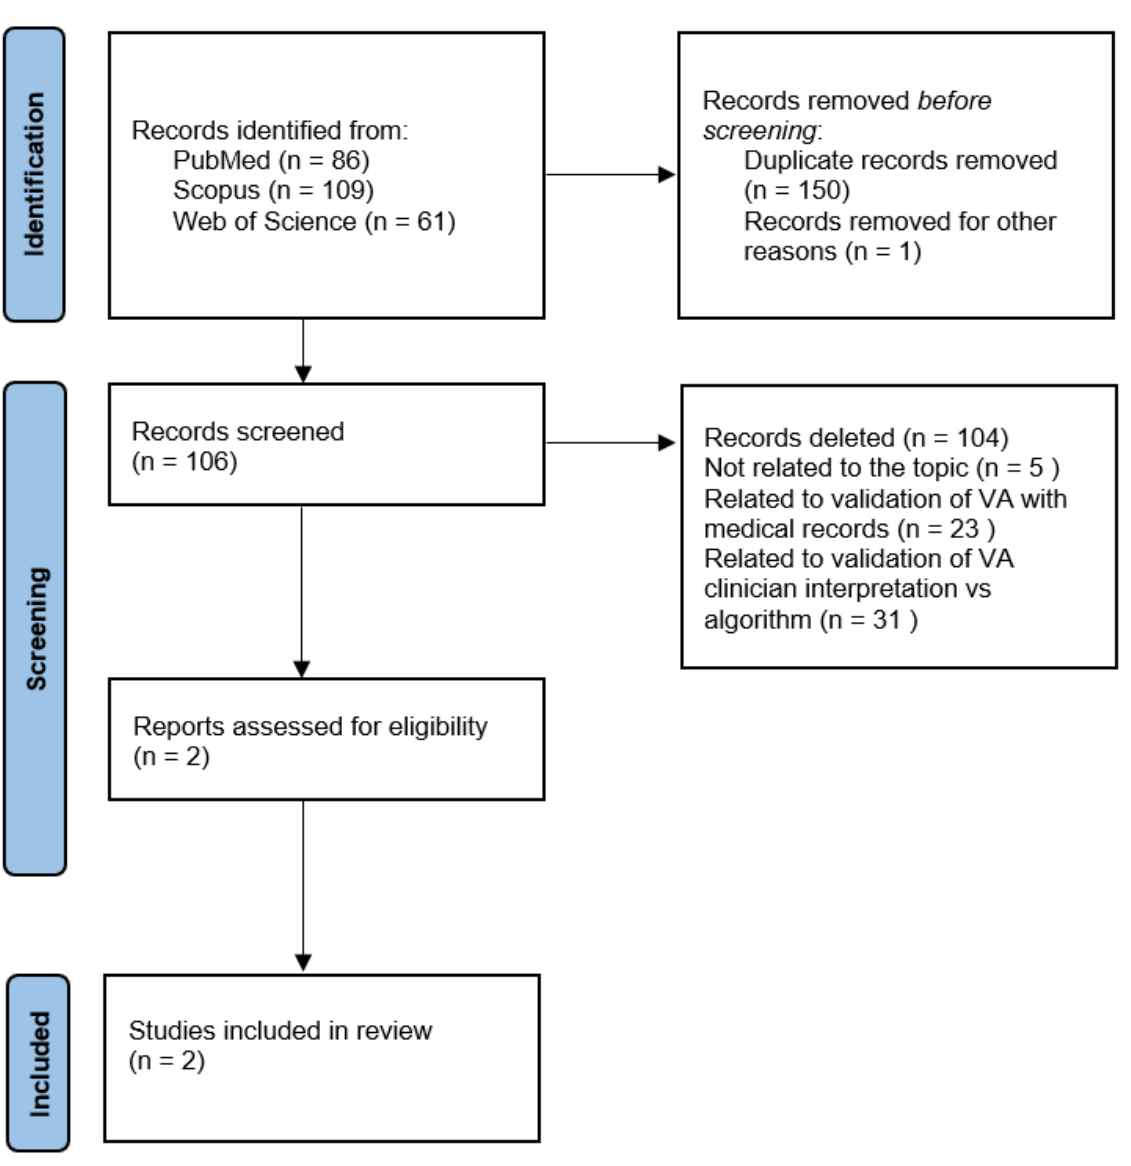
Figure 1. Review search strategy.